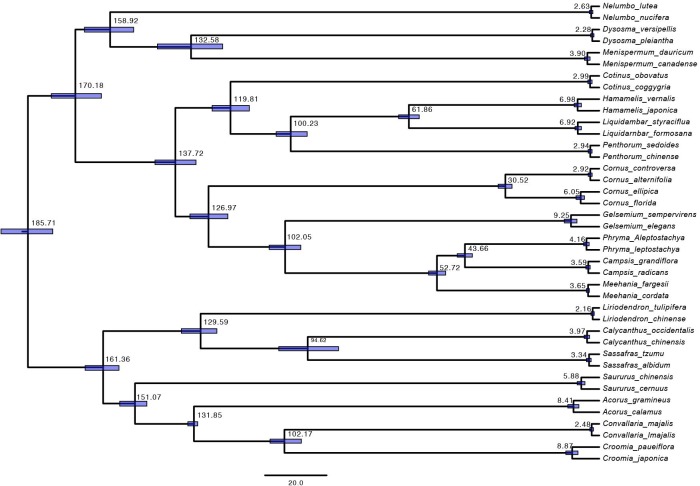
Divergence times of 20 taxon pairs estimated with 79 single copy orthologs present in 90% or more species using BEAST.